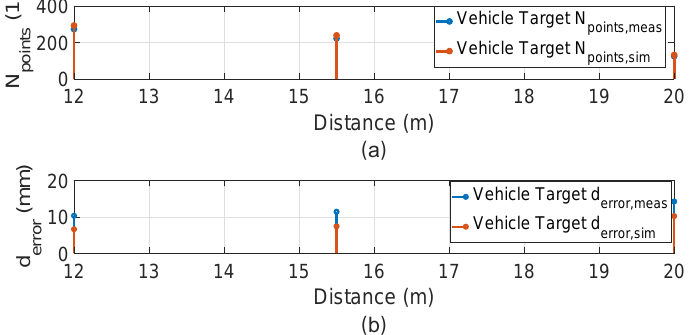
Figure 28. ( a ) Comparison of the number of points N points received from the surface of the simulated and real vehicle. ( b ) Comparison of the real and virtual LiDAR sensor distance error d error for the vehicle target. The distance error d error is below the MPE ±